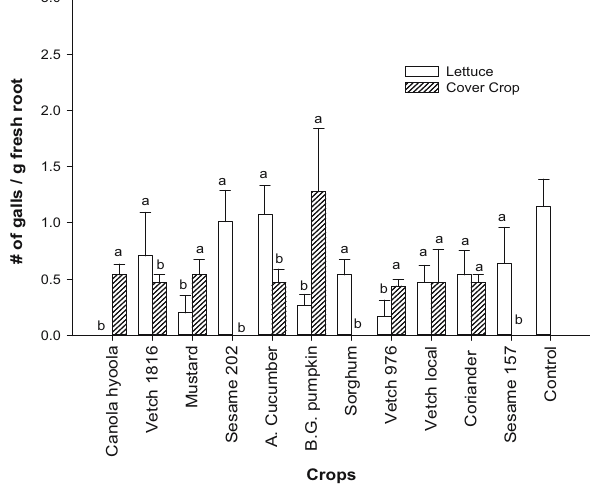
Figure 9: The total number of RKN galls per gram fresh root in the root systems of the host plant lettuce ( Lactuca sativa L. ) planted with 11 local non - host crops as trap plants. The standard deviation of the means is designated by the error bar for each mean. Means followed by the same letter are not signi fi cantly di ff erent ( SNK, P > 0.05 )